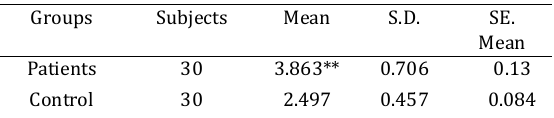
Table 2. Plasma Fibrinogen results for patient and control groups.